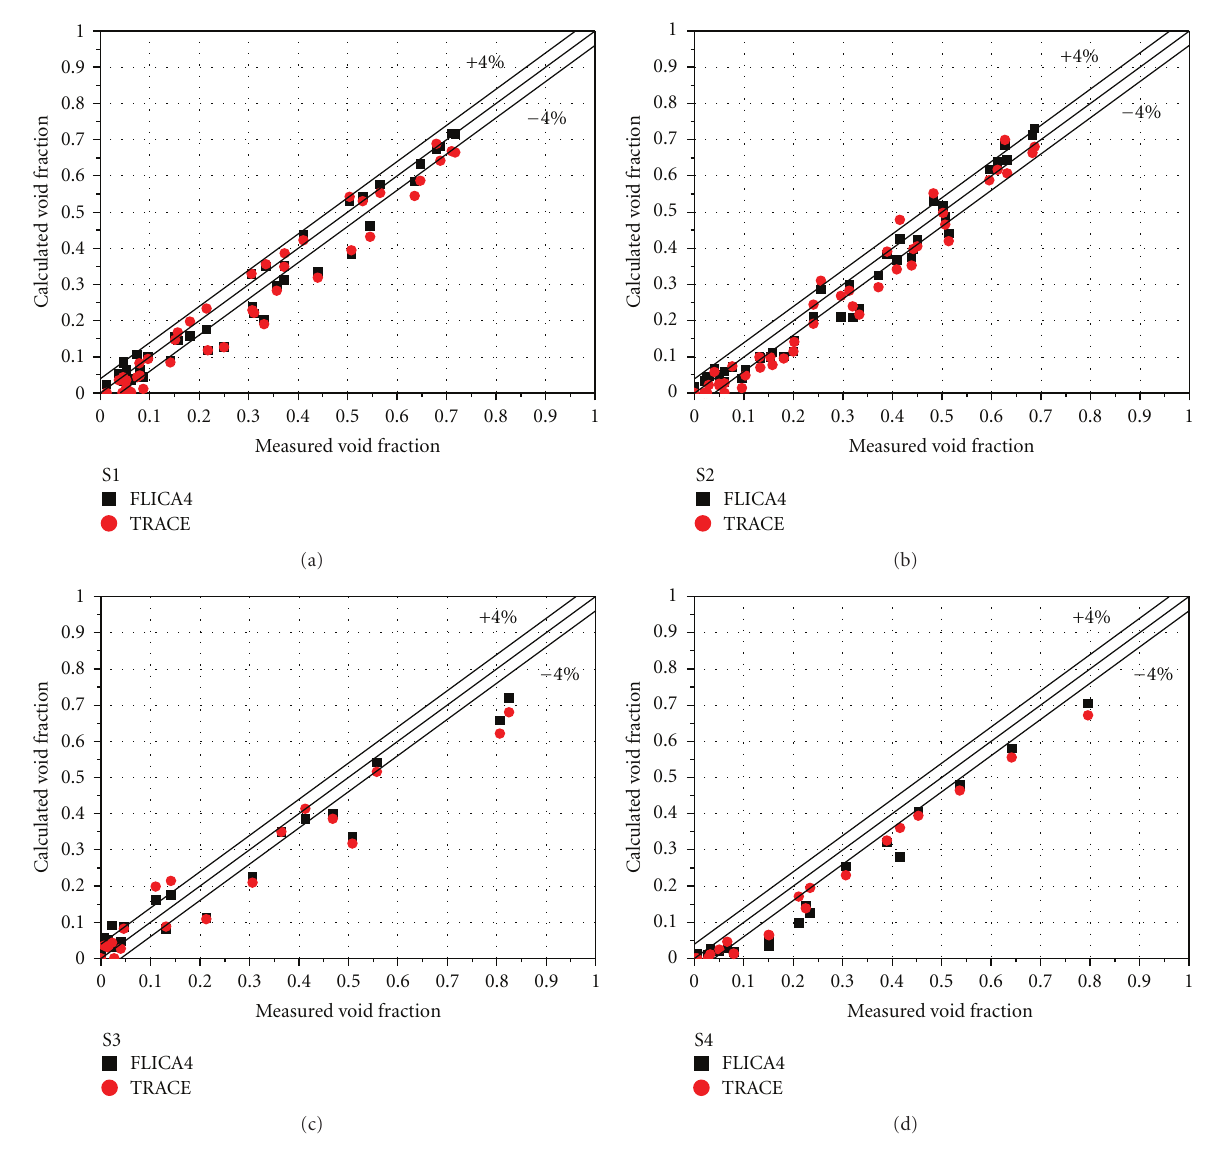
Figure 5: Void fraction predictions for single-channel exercise.